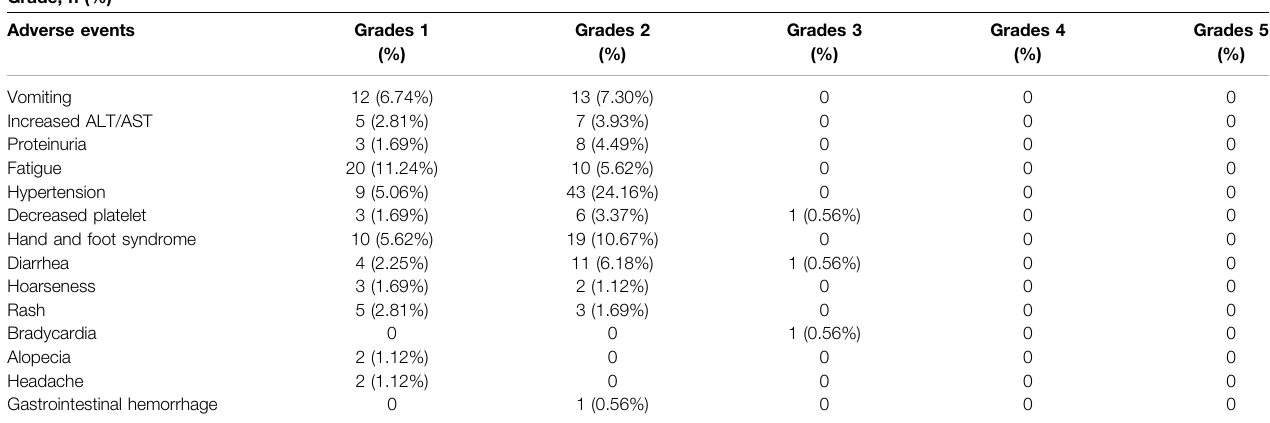
TABLE 5 | All adverse reactions in the patients after taking apatinib. Grade, n (%) Adverse